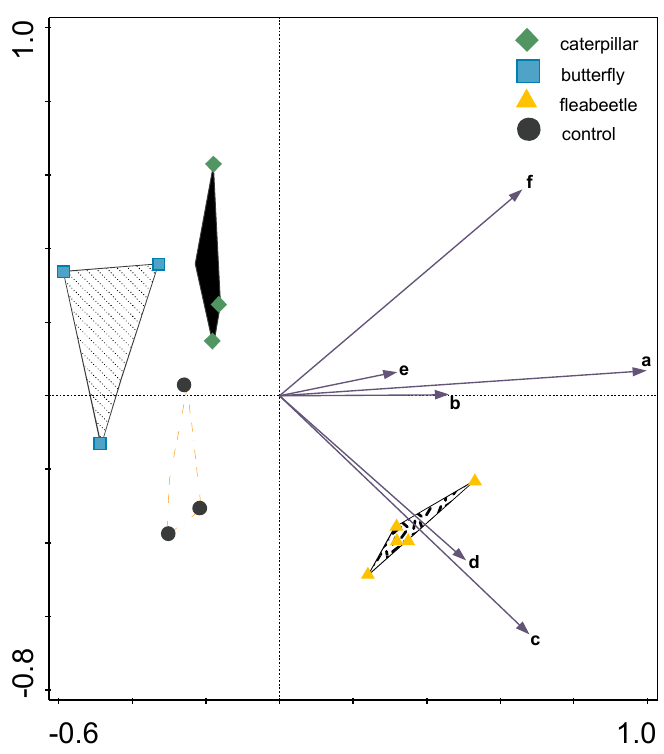
Figure 5. The principal component analysis (PCA) includes Figure 1 compounds and the Euclidean distances between particular samples. The total variation was 10.6. The explained variation on first two axes was 86.15%.